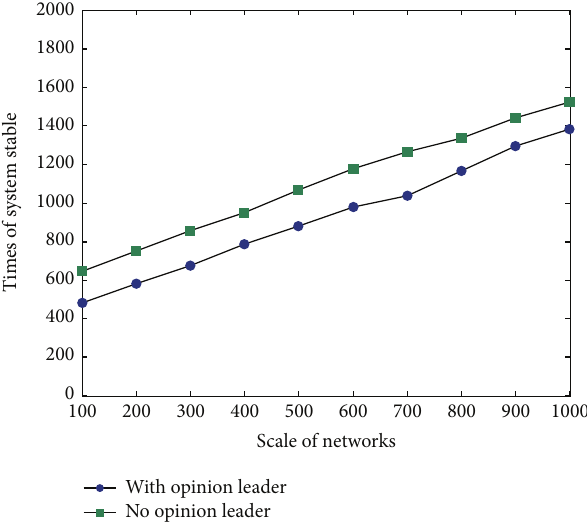
Figure 12: Influence of opinion leader on the times of system stable under different scale of networks. It takes less time to achieve system stable after appearance of opinion leader. Each data point is an average over 30 independent